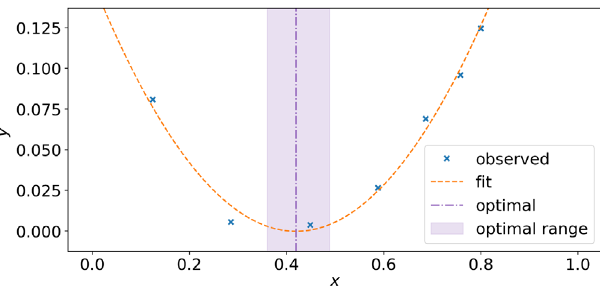
FIG. 3. Parabola fitting at the end of exploration. The purple dashed vertical line indicates the peak position found by the fitting, and the purple region around the peak line shows the uncertainty of the peak position, calculated by the covariance matrix of the parabola